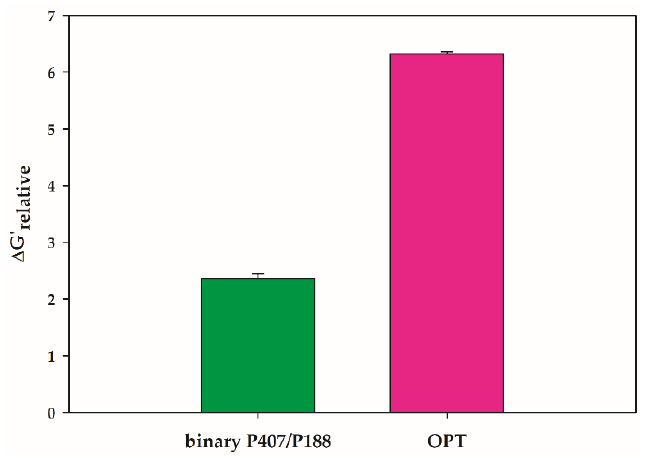
Figure 5. Relative rheological synergism ( Δ G’ relative ) of OPT and the mixture of 20.000% P407 and 7.349% P188 (binary P407/P188).